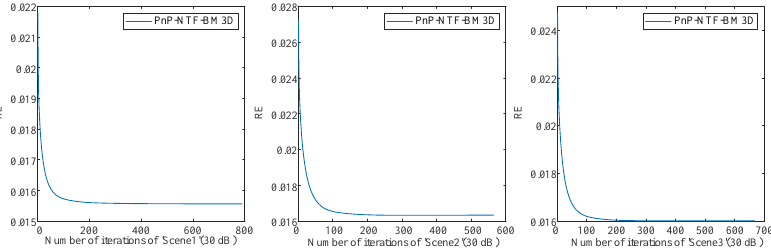
Figure 7. Iterations of RE with